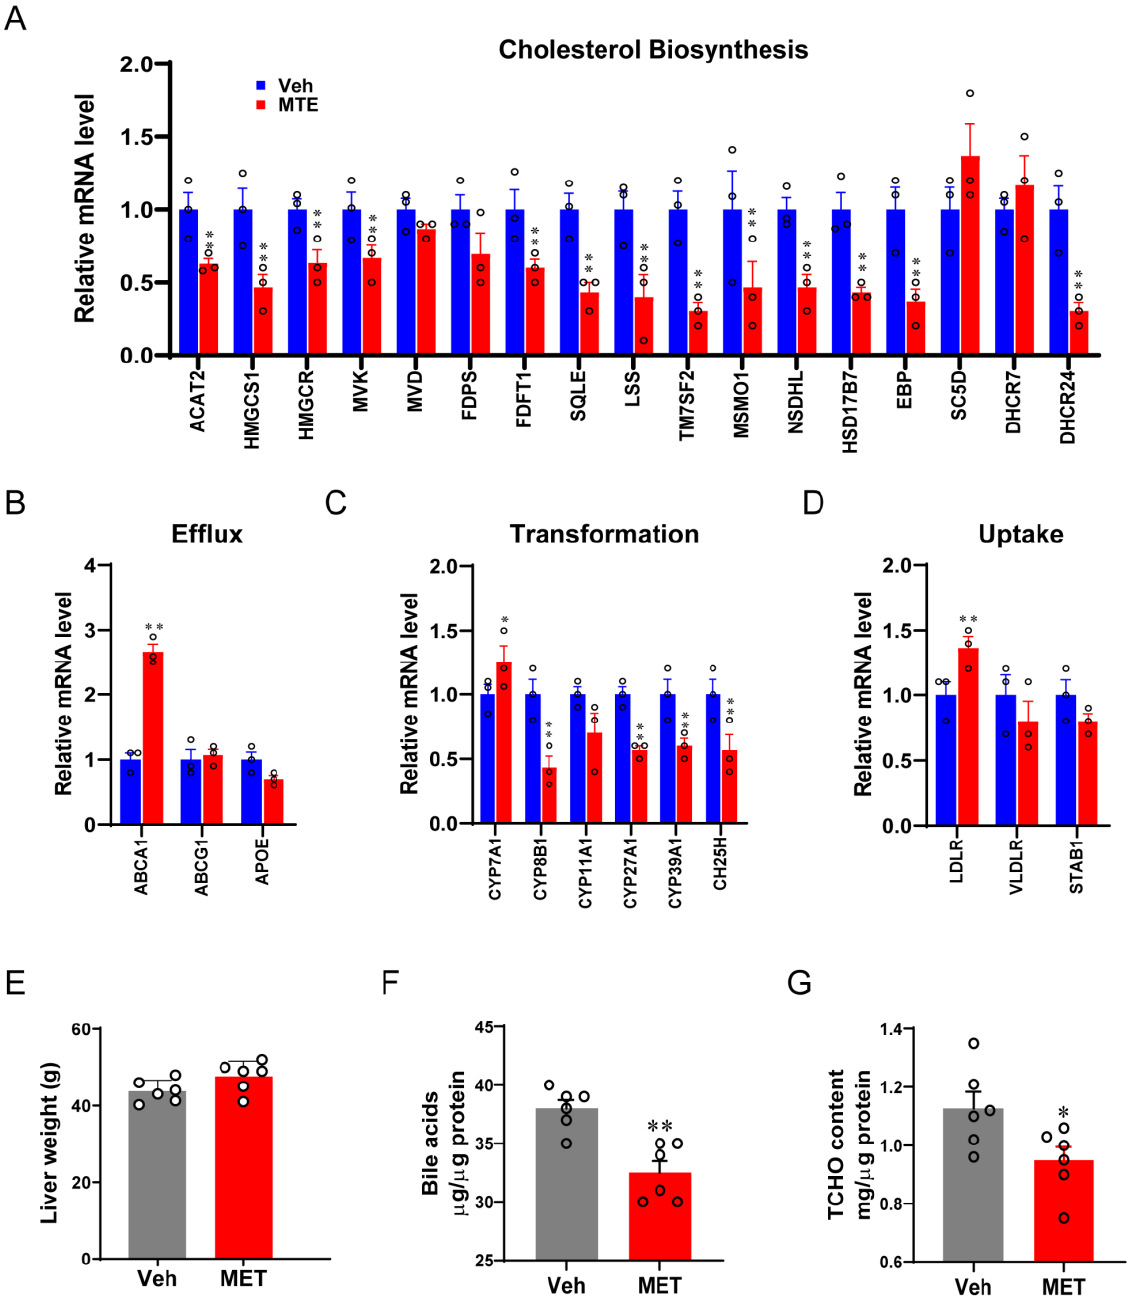
Figure 3. Mycotoxin exposure decreases cholesterol and bile acids synthesis. ( A – D ) Cholesterol metabolism gene transcripts measured by qRT-PCR in control or mycotoxin-exposed piglet livers. ( E ) The liver weight was measured in two groups. ( F ) Liver bile acid concentrations and ( G ) total cholesterol (TCHO) contents were tested. The data are shown as the means ± SEM, n = 6, * p < 0.05, ** p < 0.01, using ANOVA with Tukey’s post hoc test.